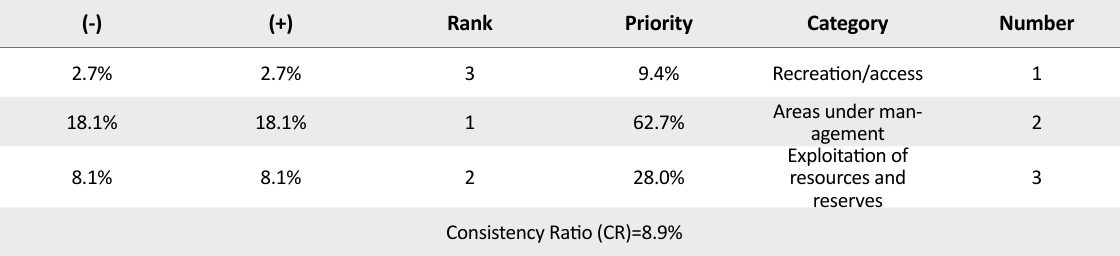
Table 3 . Weight of sub-criteria of resources used by